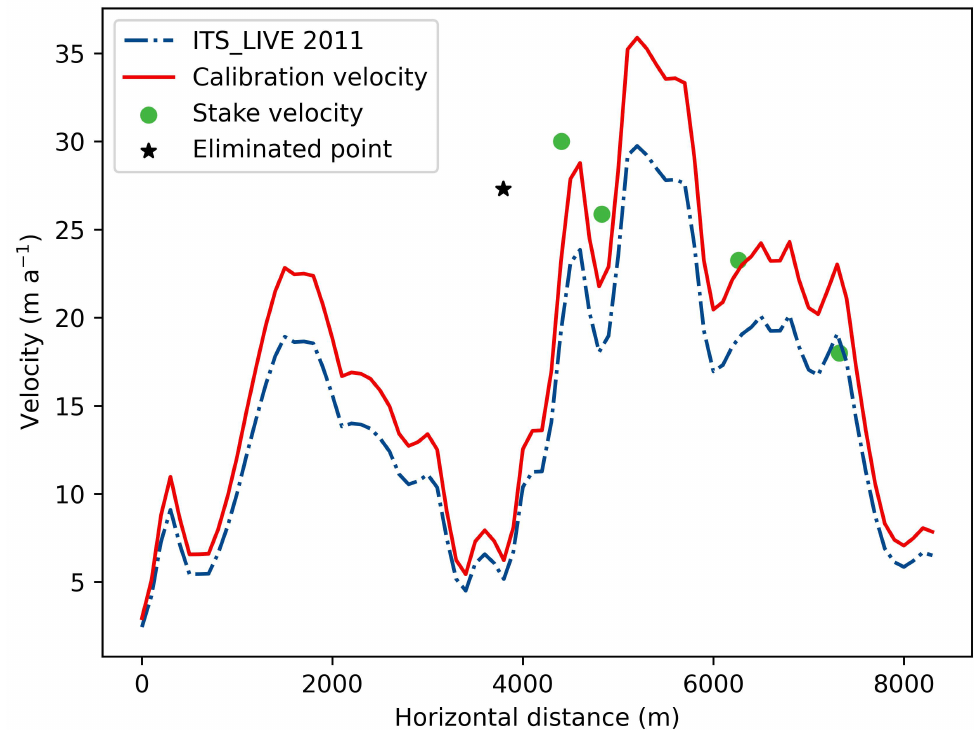
Figure 3. Surface velocities of JMYZG (the blue dash-dotted line is the original ITS_LIVE data in 2011 (initial state); the red solid line is the calibrated ITS_LIVE data; the green solid points represent the stakes used for calibration; the black star point represents the stake that does not participate in the velocity correction for a large